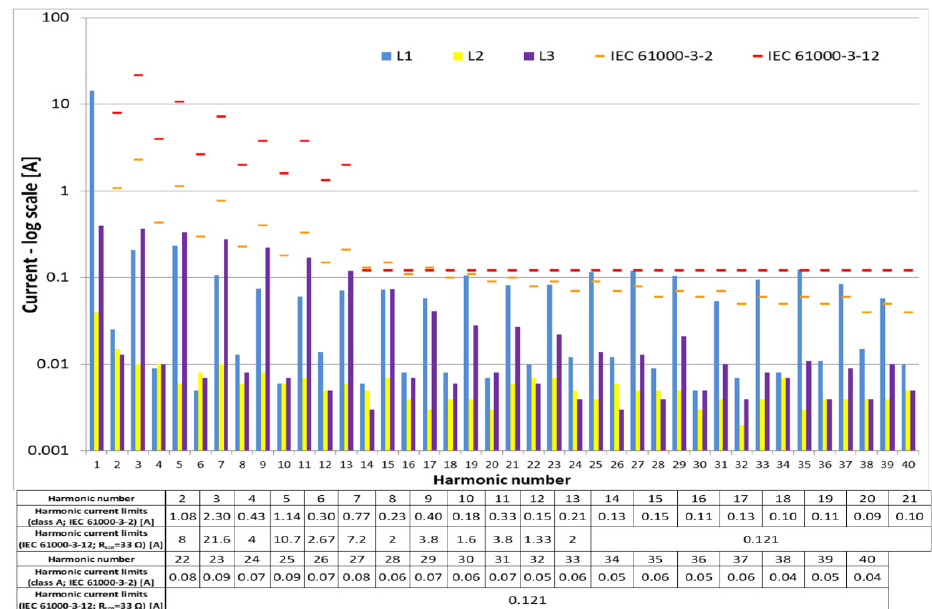
Figure 6. The harmonic current emissions when charging a BMW i3 compared with the limits of the IEC 61000 ‐ 3 ‐ 2 standard and IEC 61000 ‐ 3 ‐ 12